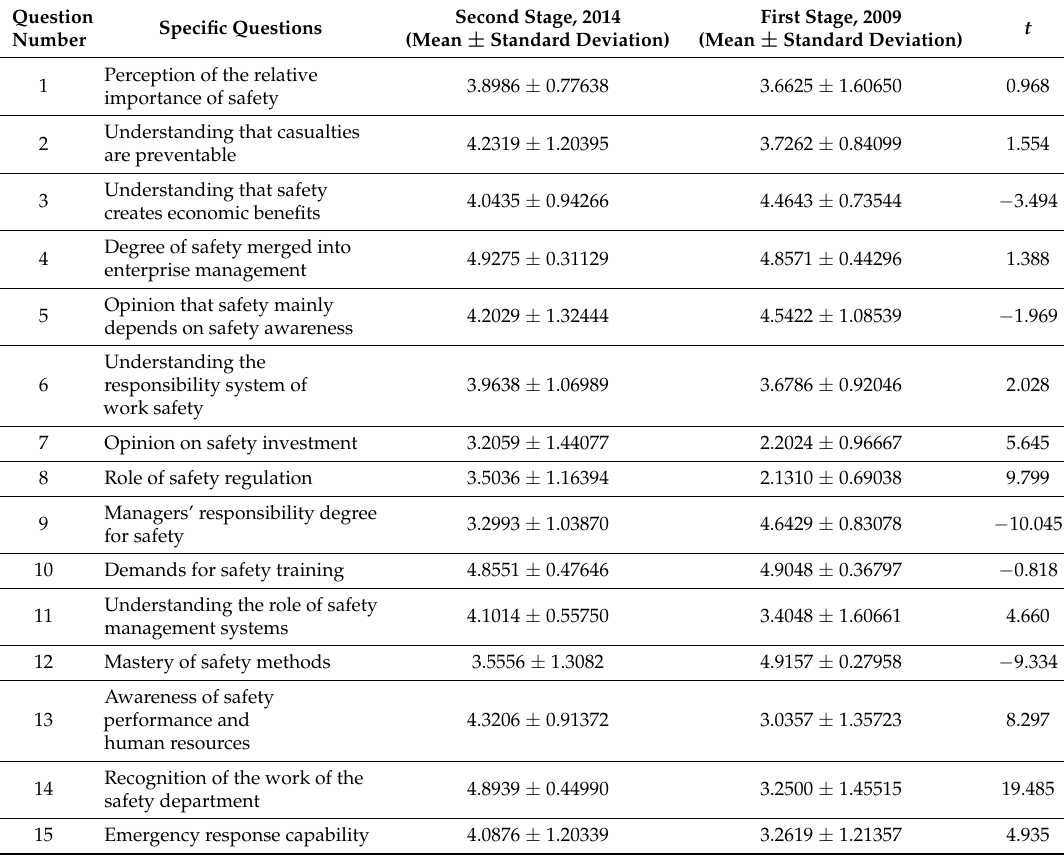
Table 2. Comparative statistics analysis of 15 evaluation concepts in 2009 and